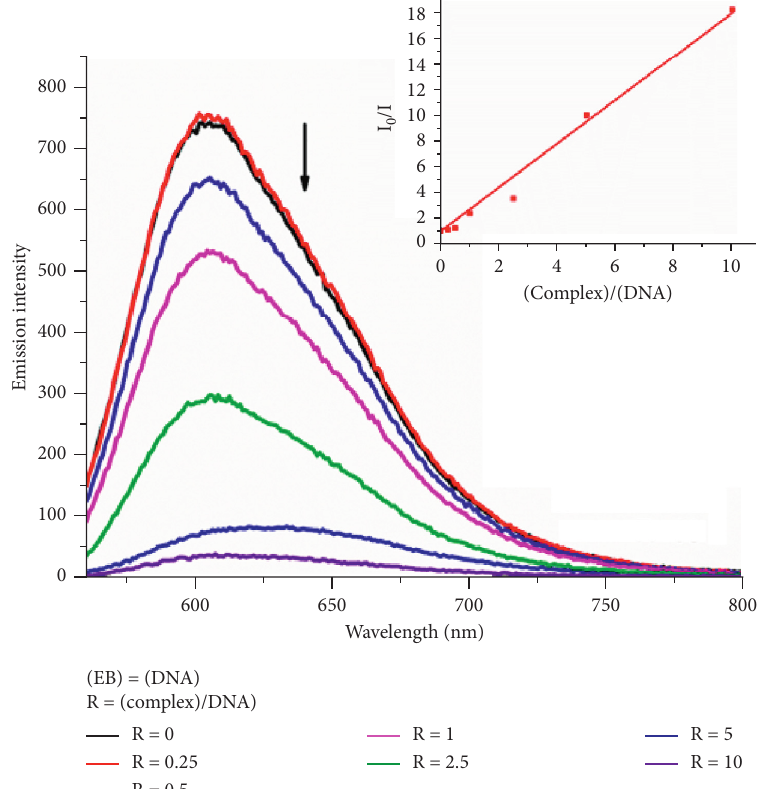
Figure 7: Emission spectra of EB bound to DNA with increasing amount of 2. (EB) � (DNA) � 1 · 10 − 4 M [Ru(bpy) (phen) (2, 2’-pq)] 2+ � 0- 10 · 10 − 4 M λ ex � 526nm, in tris-HCl buffer solution. Stern–Vomer plot of I 0 / I vs. r (where r � (complex 2)/(DNA)) of the fluorescence titration.